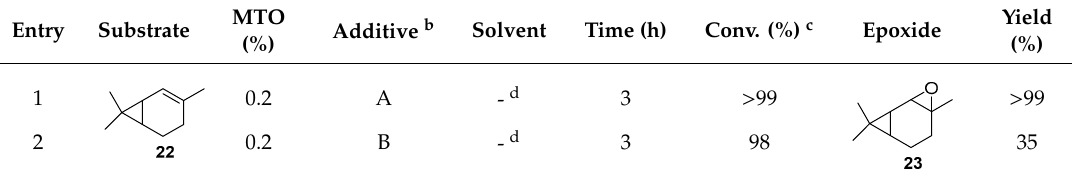
Table 2. Methyltrioxorhenium(MTO)-catalyzed epoxidation of various terpenes—Optimization a (adapted from reference [17]).